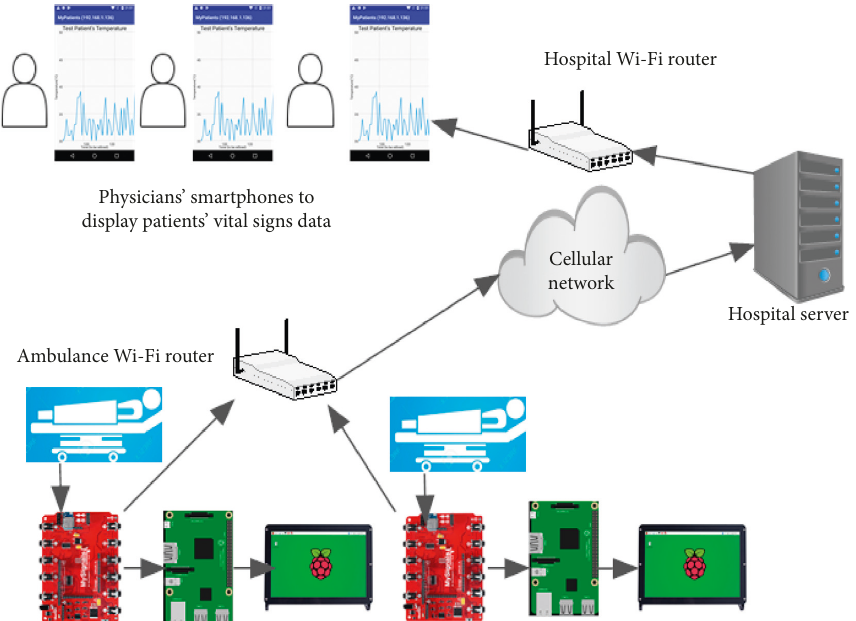
Figure 4: Connection of the ambulance Wi-Fi network with the cellular network.